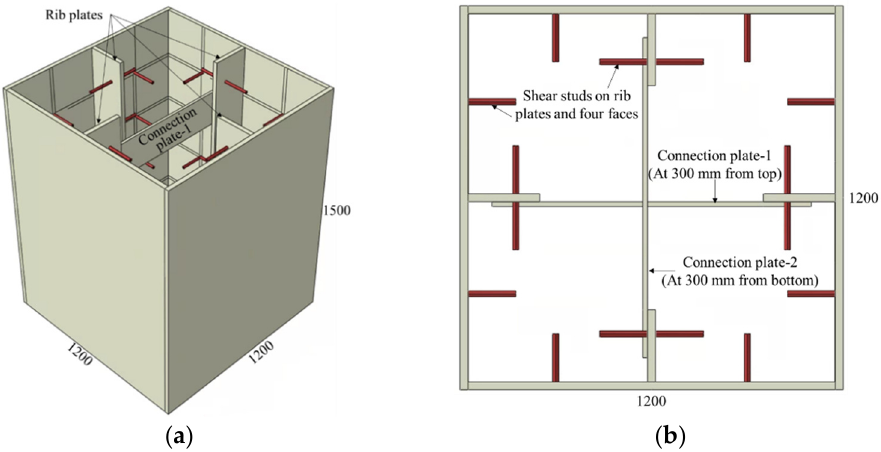
Figure 6. CFST column with rib plate, shear stud, and connecting plates: ( a ) 3D view and ( b ) top view. Table 3. List of finite-element models with rib plate and shear stud connectors.